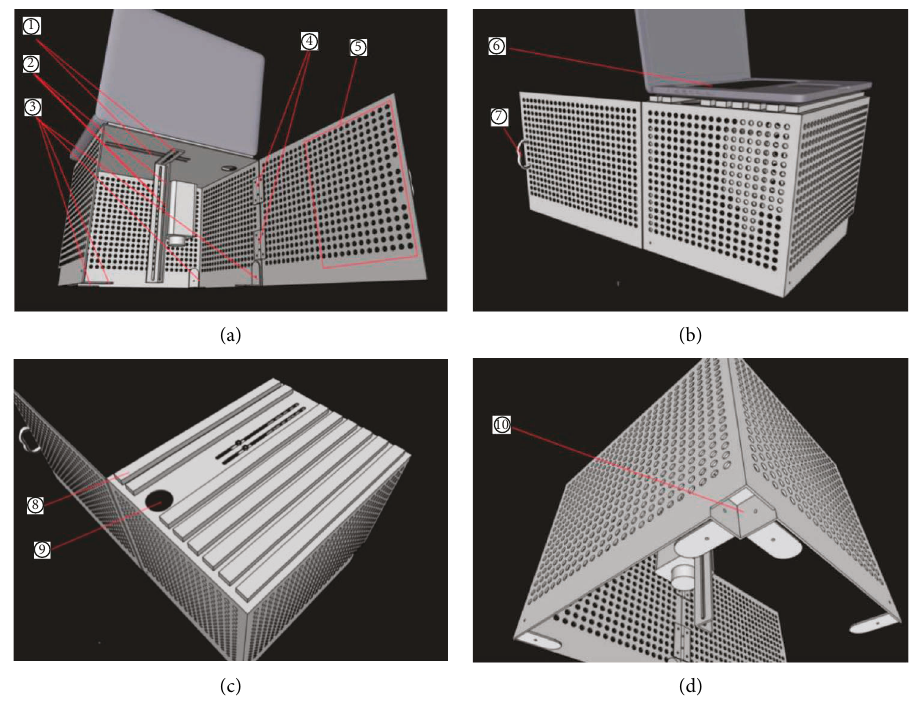
Figure 2: Three-dimensional movable camera bin. (a) The front. (b) The side. (c) The top. (d) The